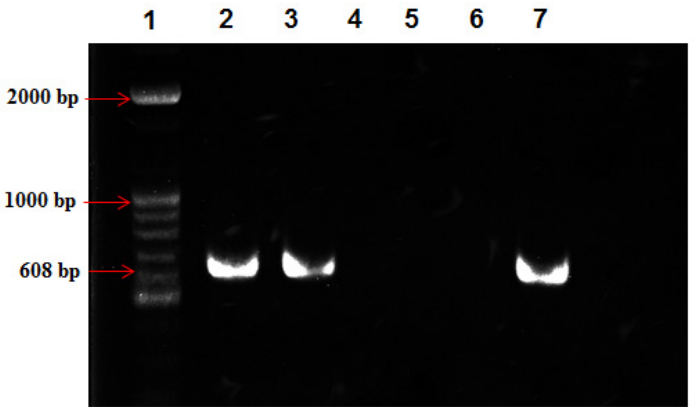
Figure 2. Discrimination between normal and abnormal melon seeds sensed by RT-PCR amplification. PCR products were separated by electrophoresis through a 1% agarose gel. Lane M, 100 base plus ladder DNA; Lane 1 and 2, abnormal seeds; Lane 3 and 4, normal seeds; Lane 5, CGMMV infected melon